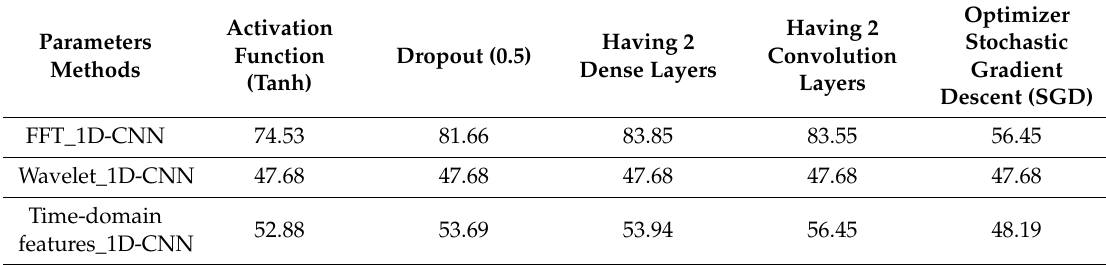
Table 5. Impact of the di ff erent parameters and methods on the accuracy of the